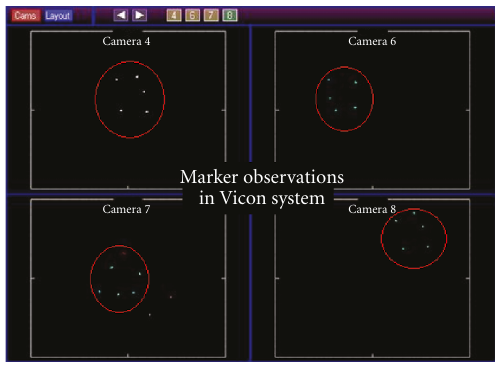
Figure 16: Reflectance markers observed by Vicon IQ